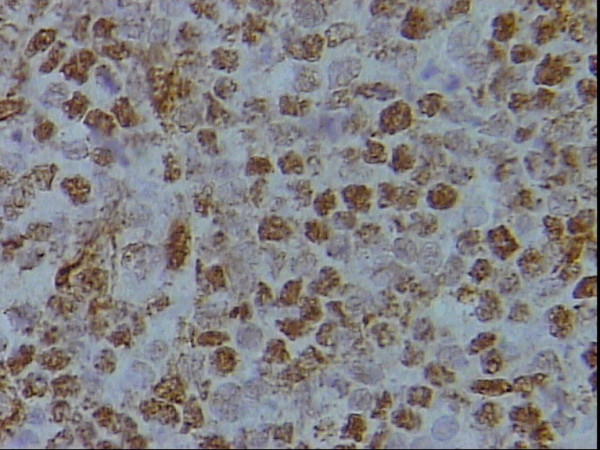
Higher power magnification of figure 4 showing moderate nuclear and rare cytoplasmic SMA staining of the neoplastic lymphocytes, DAB, Hx, × 40.